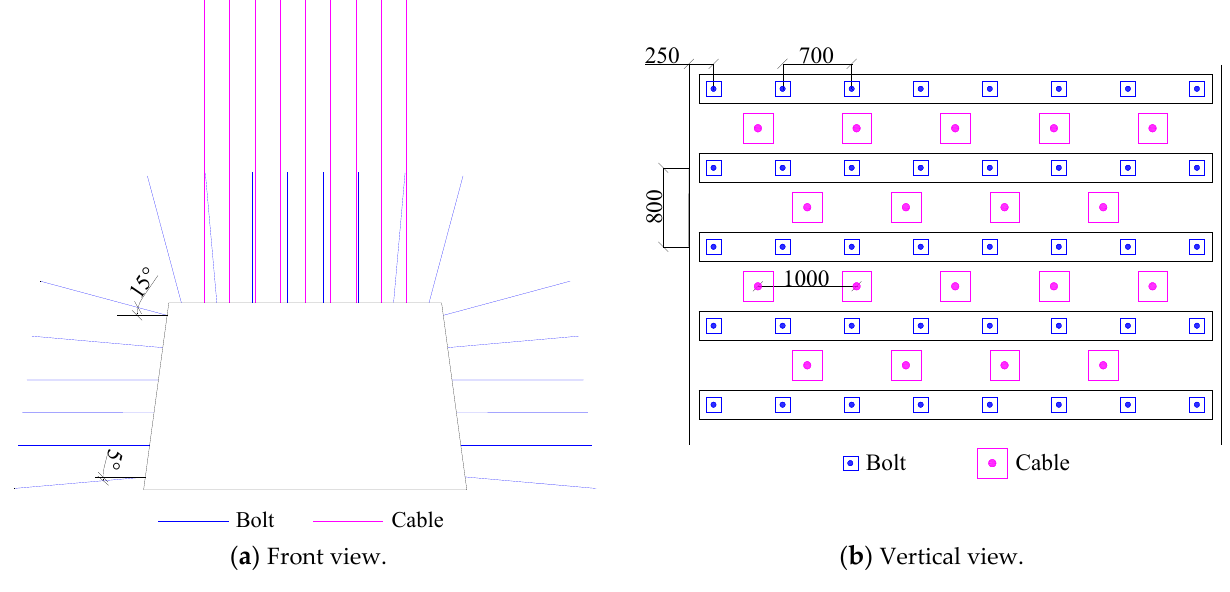
Figure 5. Schematic diagram of roadway support.